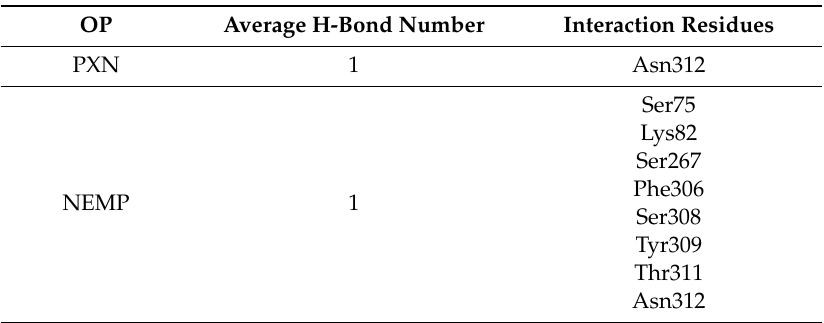
Table 2. H-bond interactions for the systems PTE/PXN and PTE/NEMP.